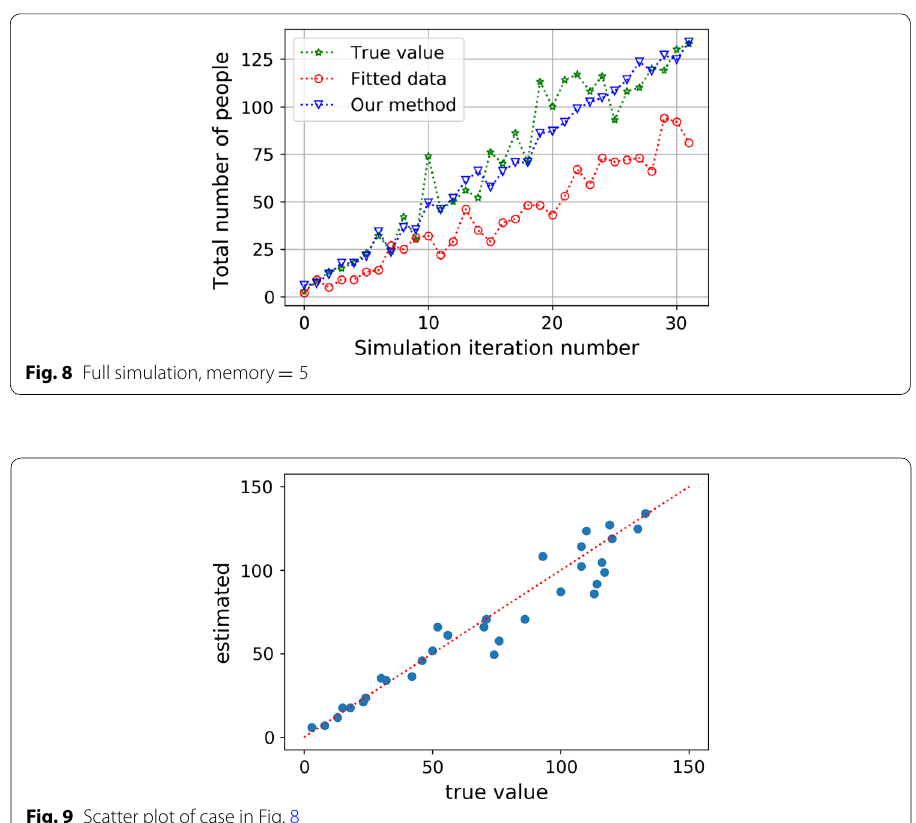
Fig. 9 Scatter plot of case in Fig.